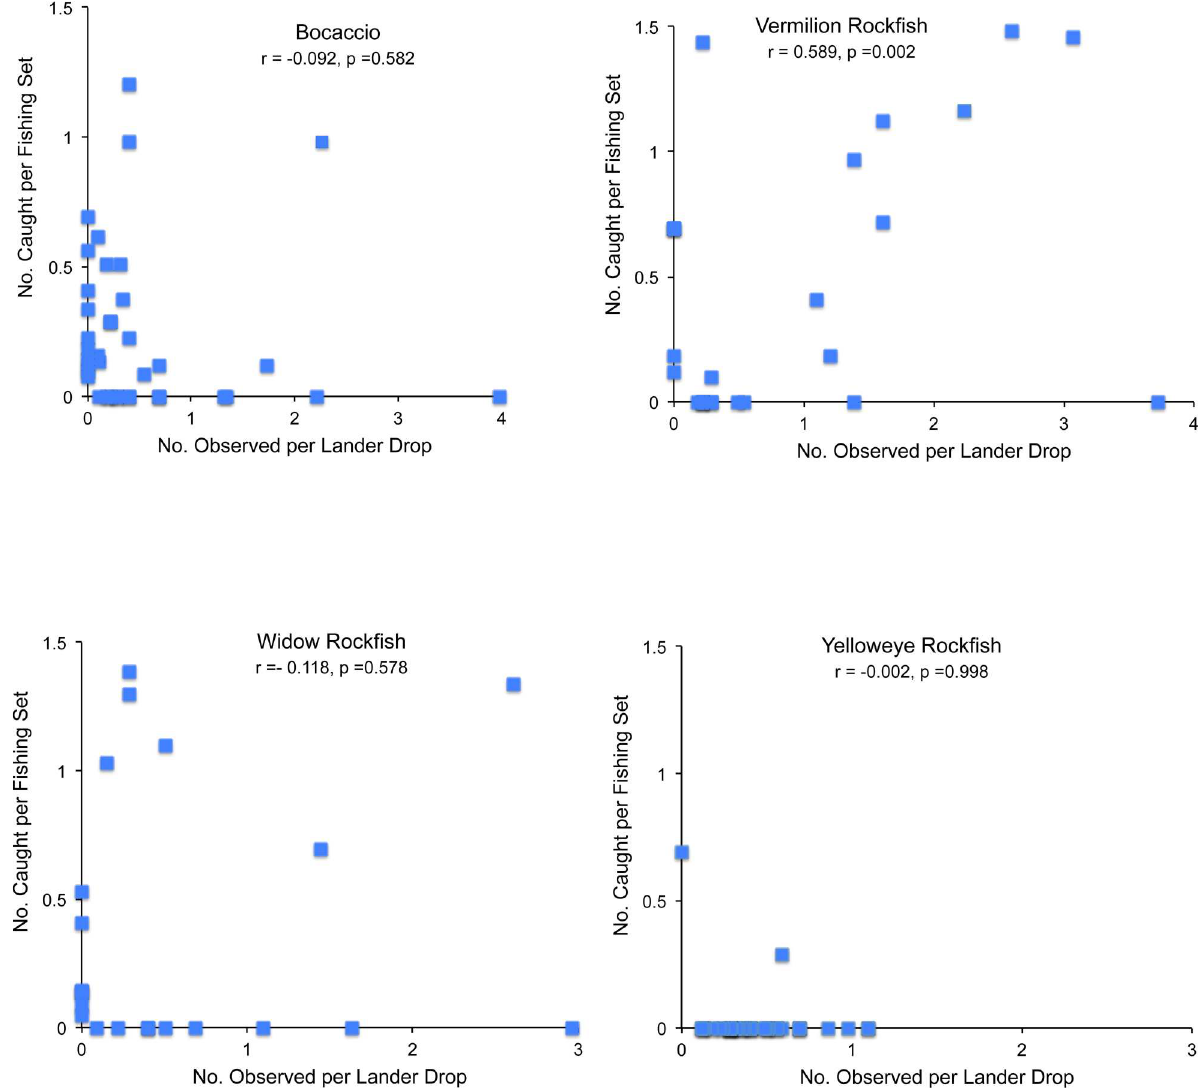
Fig 5. Example of the relationship between the number of fish caught in experimental fishing sets and the number observed in video surveys for Bocaccio, Vermilion Rockfish, Widow Rockfish, or Yelloweye Rockfish. Catches and observationswere ln (x+1)